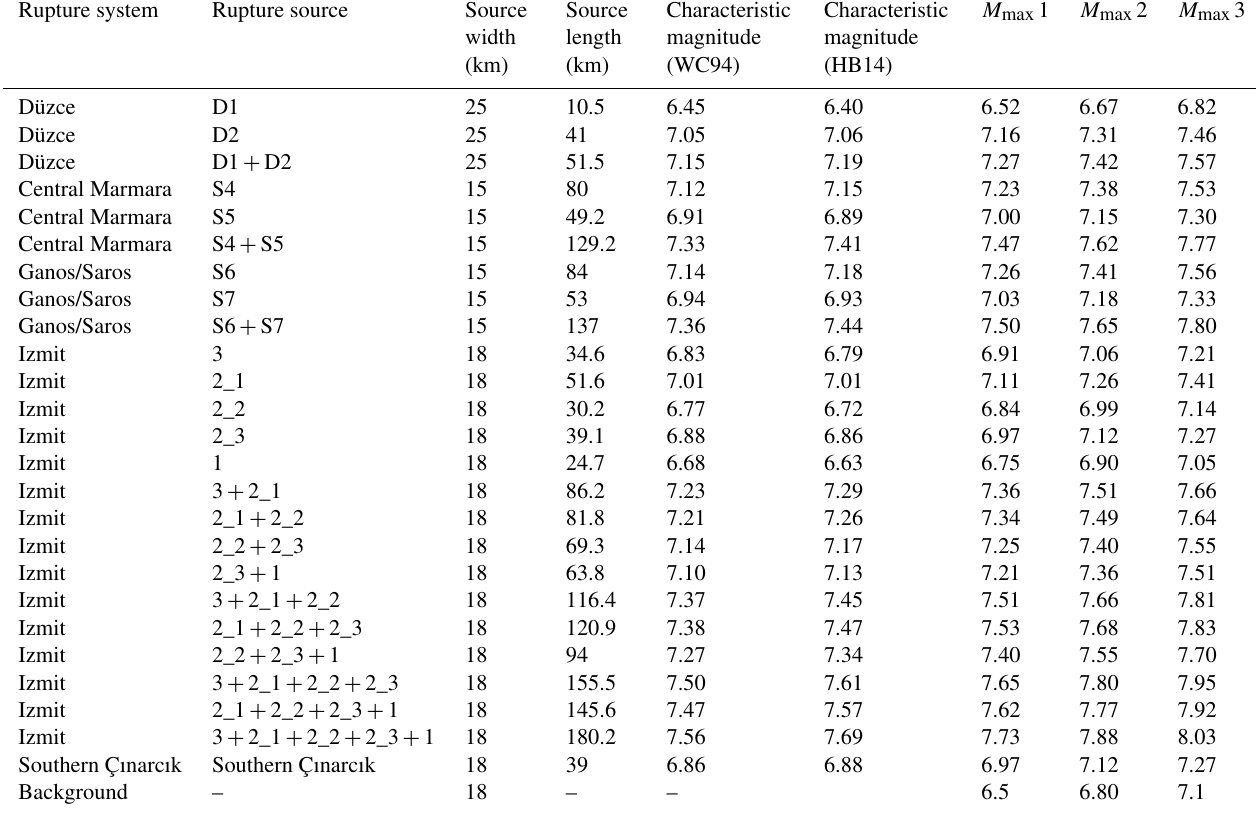
Table 6. Logic tree representing epistemic uncertainty in maximum magnitudes. Weights for M max 1, M max 2, and M max 3 are 0.25, 0.5, and 0.25, respectively (WC94: Wells and Coppersmith, 1994, and HB14: Hanks and Bakun, 2014, magnitude–rupture-area